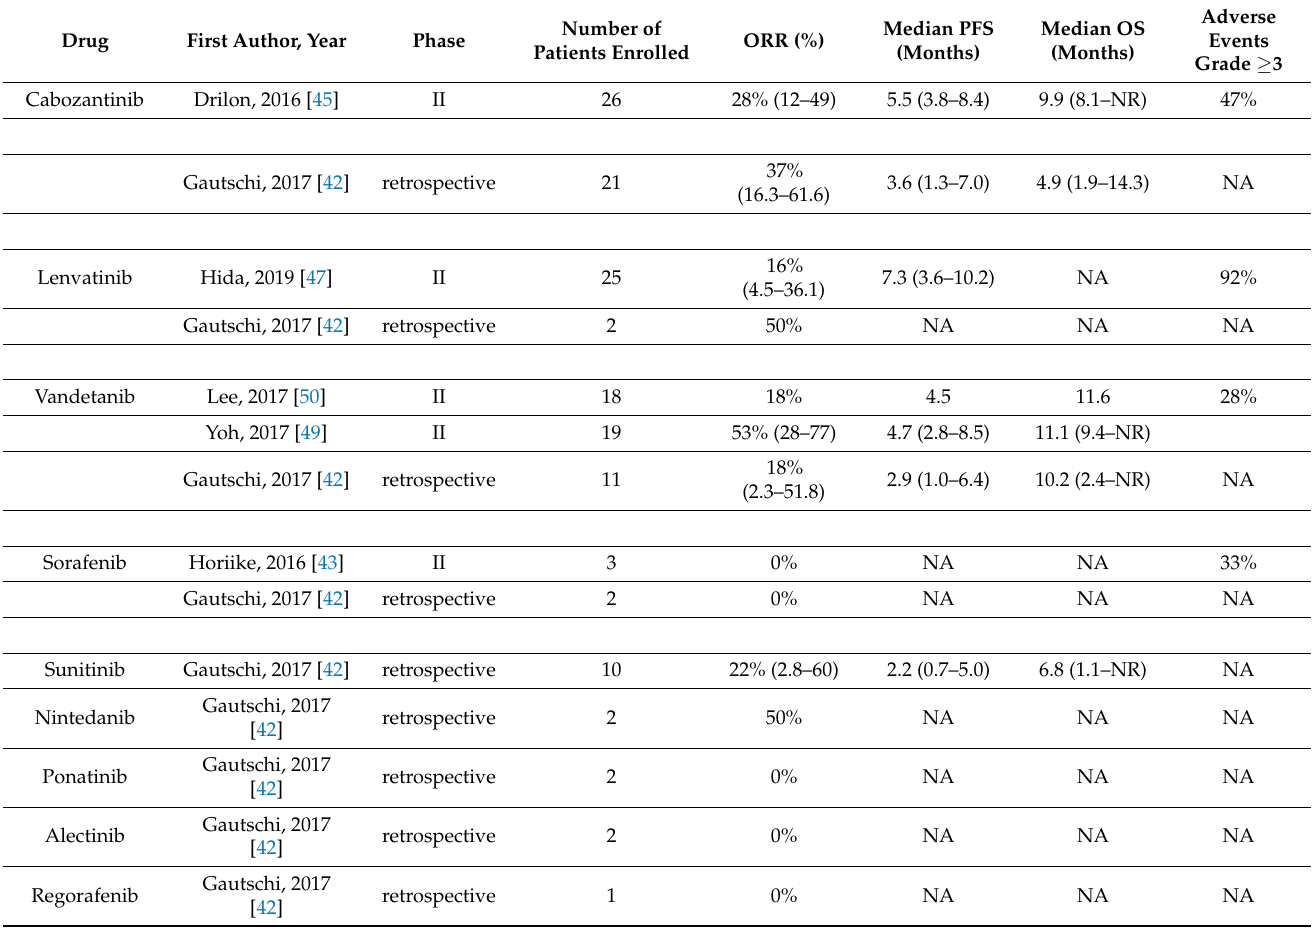
Table 1. Prospective/Retrospective Clinical Trials of Multikinase Inhibitors (MKIs) in RET-Rearranged Non-Small Cell Lung